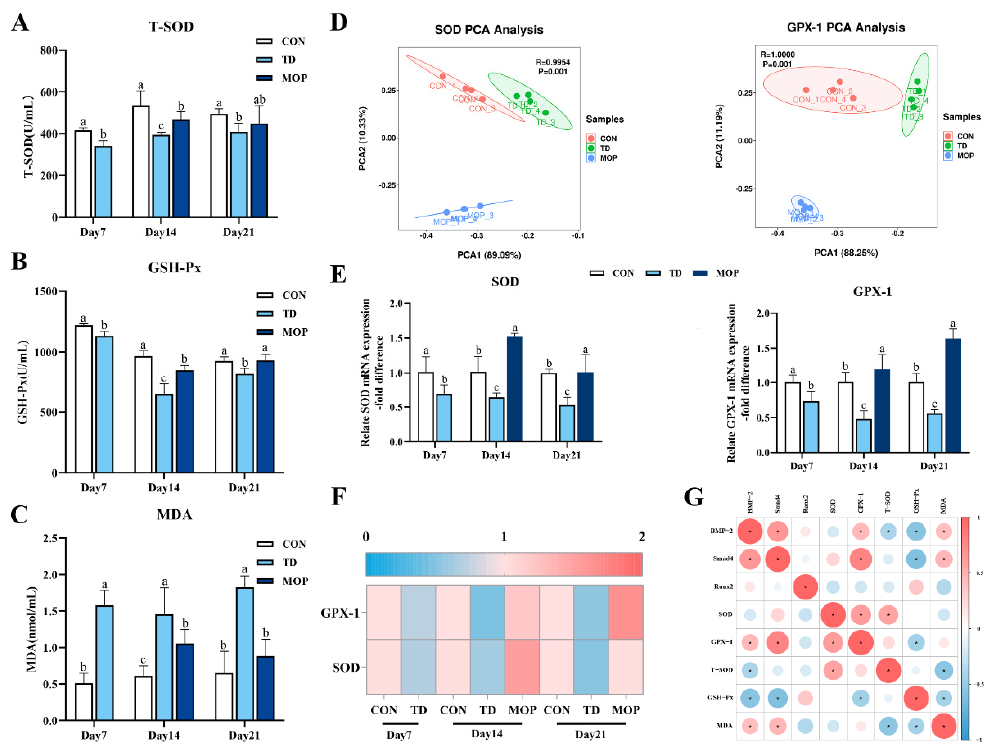
Figure 5. Effect of MOP on the antioxidant ability of broilers. ( A ) Plasma T-SOD activity. ( B ) Plasma GSH-Px activity. ( C ) Plasma MDA level. ( D ) PCA of the SOD, GPX-1 gene expressions with an unsupervised pattern recognition method. ( E ) SOD, GPX-1 gene expression. ( F ) Heatmap shows the expression of genes associated with antioxidant activity. ( G ) Pearson correlation analysis between antioxidant indices and BMP/Smads signaling pathway. Bars with no common small letters (a, b, c) indicate statistical differences among the three treatments ( p < 0.05).